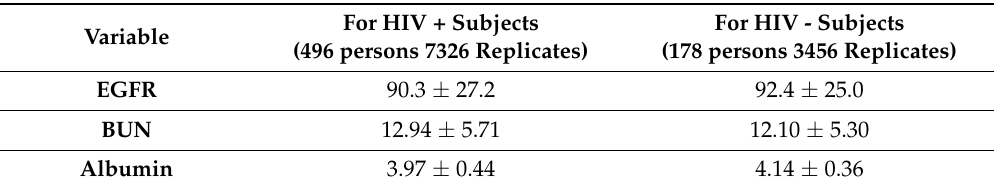
Table 3. Means ± standard deviation of EGFR serum albumin and BUN broken down by HIV status across all repeated measures used in Tables 1 and 2.